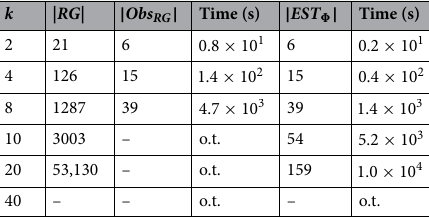
Table 2. Performance of Algorithm 3.